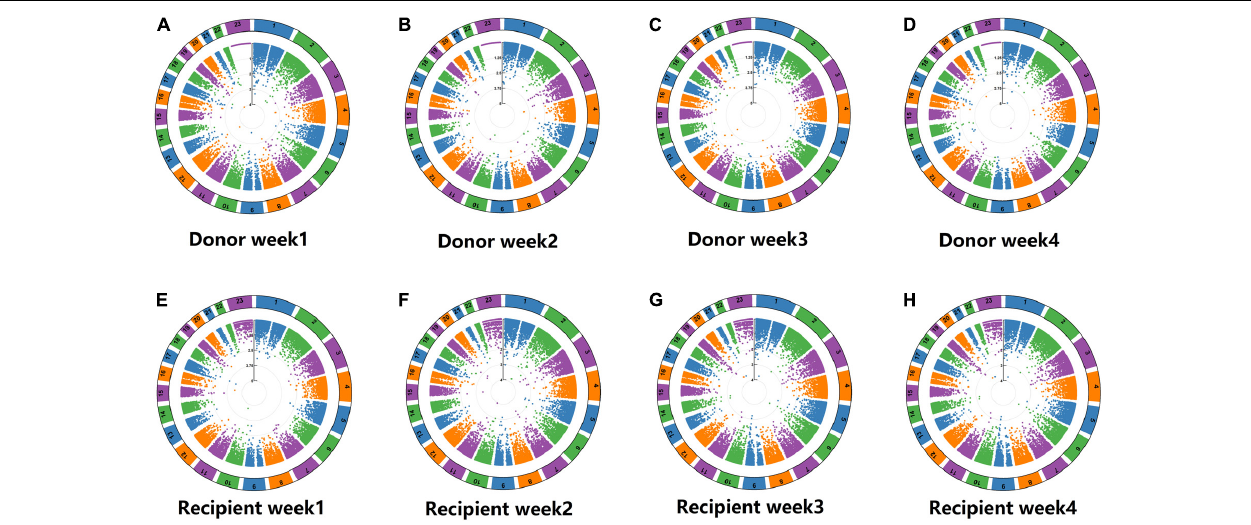
FIGURE 1 | Manhattan plots of single-nucleotide polymorphisms (SNPs) associated with ln(TAC C 0 /D ratio) in donors and recipients respectively. Total > 240,000 markers were analyzed toward natural log of dose-normalized tacrolimus trough concentrations between donors and recipients in the first 4 weeks with adjustment of age, donor gender, gender and BMI. All SNPs were shown in order from chromosome 1 to 23 (not including Y chromosome). (A) Manhattan plots of single-nucleotide polymorphisms (SNPs) associated with ln(TAC C 0 /D ratio) in donors in week 1. (B) Manhattan plots of single-nucleotide polymorphisms (SNPs) associated with ln(TAC C 0 /D ratio) in donors in week 2. (C) Manhattan plots of single-nucleotide polymorphisms (SNPs) associated with ln(TAC C 0 /D ratio) in donors in week 3. (D) Manhattan plots of single-nucleotide polymorphisms (SNPs) associated with ln(TAC C 0 /D ratio) in donors in week 4. (E) Manhattan plots of single-nucleotide polymorphisms (SNPs) associated with ln(TAC C 0 /D ratio) in recipients in week 1. (F) Manhattan plots of single-nucleotide polymorphisms (SNPs) associated with ln(TAC C 0 /D ratio) in recipients in week 2. (G) Manhattan plots of single-nucleotide polymorphisms (SNPs) associated with ln(TAC C 0 /D ratio) in recipients in week 3. (H) Manhattan plots of single-nucleotide polymorphisms (SNPs) associated with ln(TAC C 0 /D ratio) in recipients in week 4.